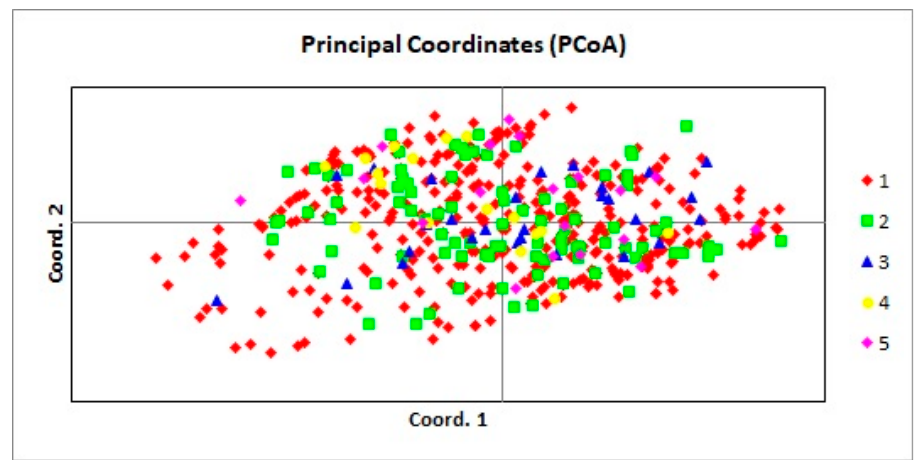
Figure 1. Principal coordinate analysis (PCoA) of all pigeons. 1—PL; 2—BE; 3—DV; 4—SK; 5—NL. Percentage of variation explained by the first 3 axes: 3.34, 2.89, and 2.45. A high level of overlapping was shown in the PCoA scatter plot of the analysis of the entire dataset. The first principal coordinate accounted for 3.34% of the total variation, while the second coordinate accounted for 2.89% of the total variation. There was no clear separation of individuals according to their origin.